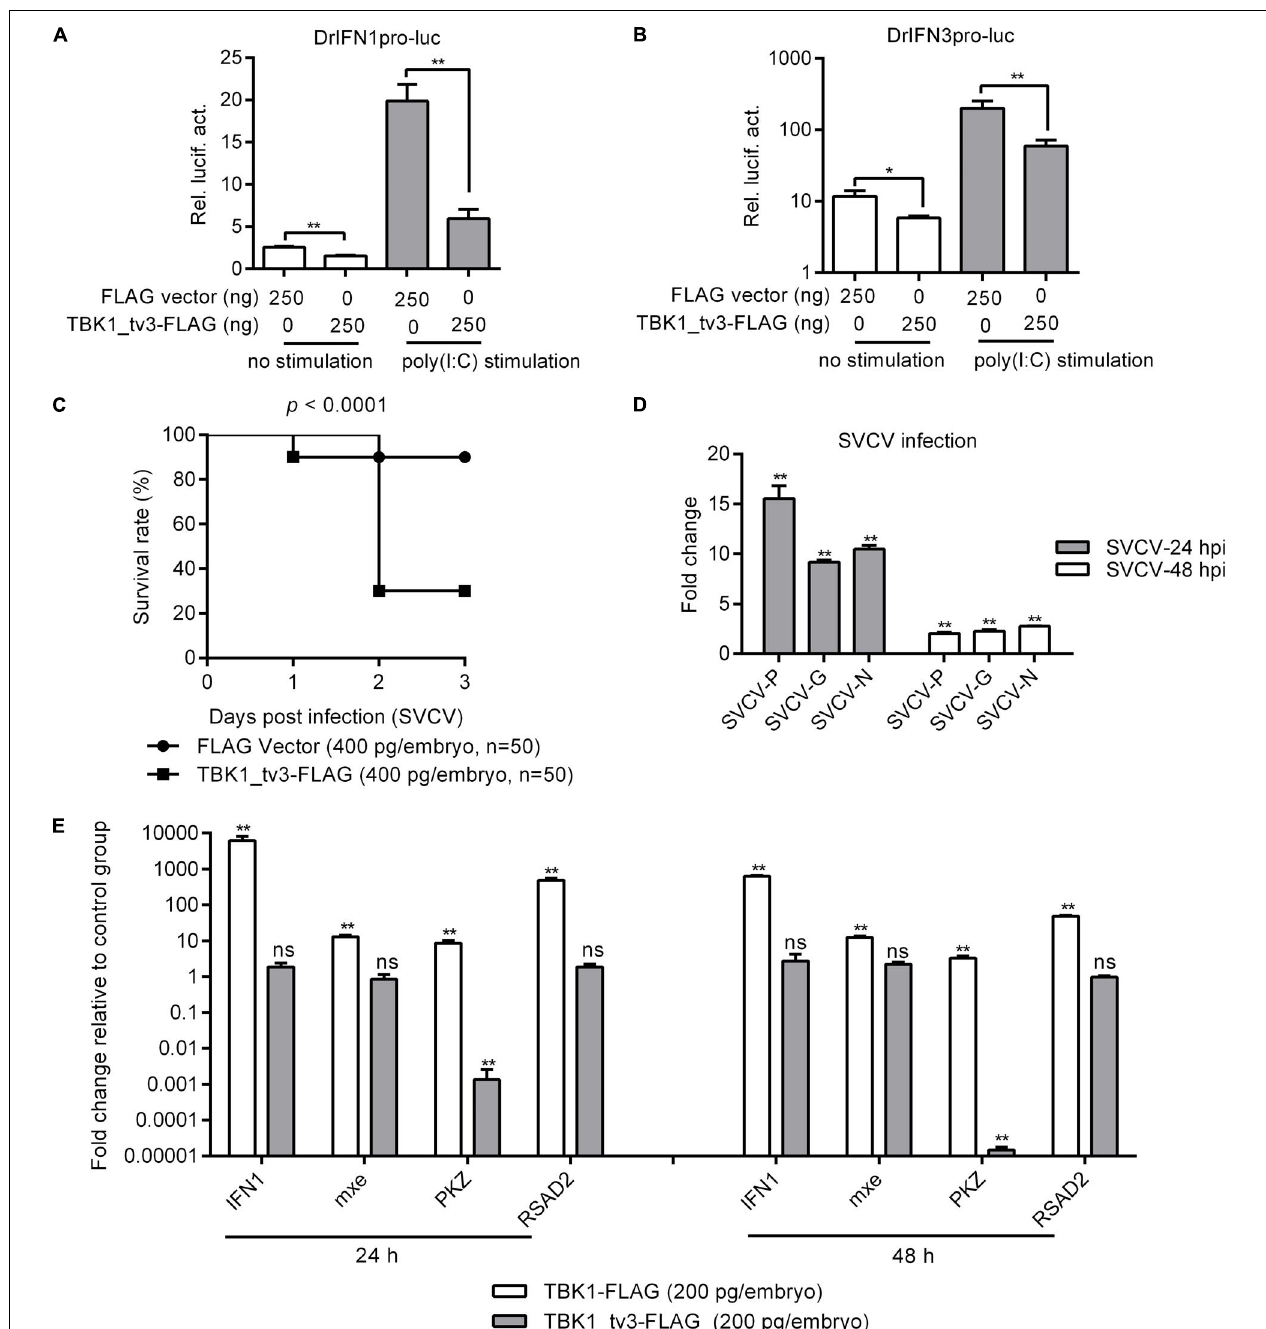
FIGURE 2 | The effect of zebrafish TBK1_tv3 on the regulation of IFNs and ISGs. (A) Effect of zebrafish TBK1_tv3 on the IFN1 (DrIFN1pro-luc) promoter with/without poly(I:C) stimulation. (B) Effect of zebrafish TBK1_tv3 on the IFN3 (DrIFN3pro-luc) promoter with/without poly(I:C) stimulation. For A,B , EPC cells seeded in 24-well plates were co-transfected with 250 ng various indicated plasmids, together with 25 ng Renilla and 250 ng IFN1 or IFN3 reporter plasmids. 24 h post-transfection, the cells were stimulated with poly(I:C) or left untreated. Another 24 h later, the cells were harvested for the detection of luciferase activity. Data represented means ± SEM ( n = 3) and were tested for statistical significance. * p < 0.05 and ** p < 0.01. (C) The overexpression of zebrafish TBK1_tv3 decreased the survival rate of zebrafish larvae infected with SVCV. (D) The overexpression of zebrafish TBK1_tv3 increased the expression of SVCV genes. For C,D , zebrafish larvae microinjected with p3XFLAG or TBK1_tv3-FLAG were infected with 2 × 10 6 PFU/ml SVCV for 24 h and monitored for 3 days. Samples were collected at 24 and 48 hpi, and used for qRT-PCR. (E) Effect of zebrafish TBK1 and TBK1_tv3 on expression of ISGs. Embryos were microinjected at the one-cell stage with 100 ng of indicated expression construct. At 24 and 48 h post-fertilization, 50 embryos for each sample were used for RNA extraction. The p3xFLAG-injected group was used for control. For all qRT-PCR, data represented the means ± the SEM ( n = 3) and were tested for statistical significance. ** p < 0.01; ns, not significant.